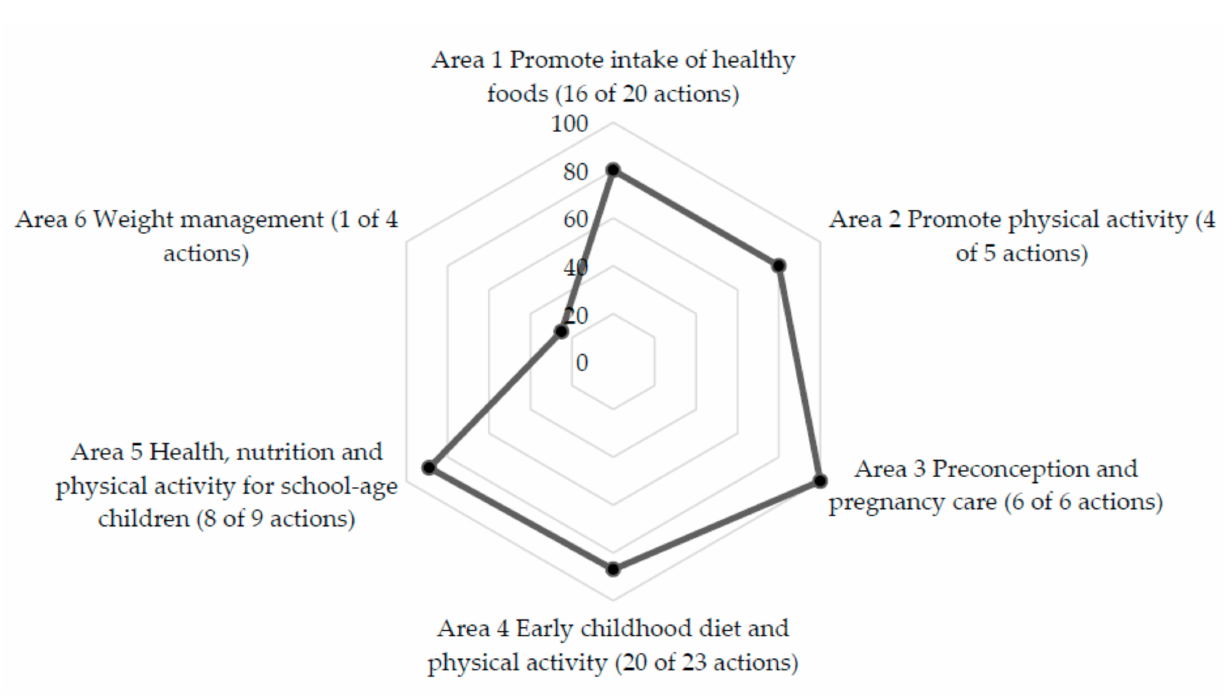
Figure 2. Specific policy actions implemented in Thailand in each of the policy